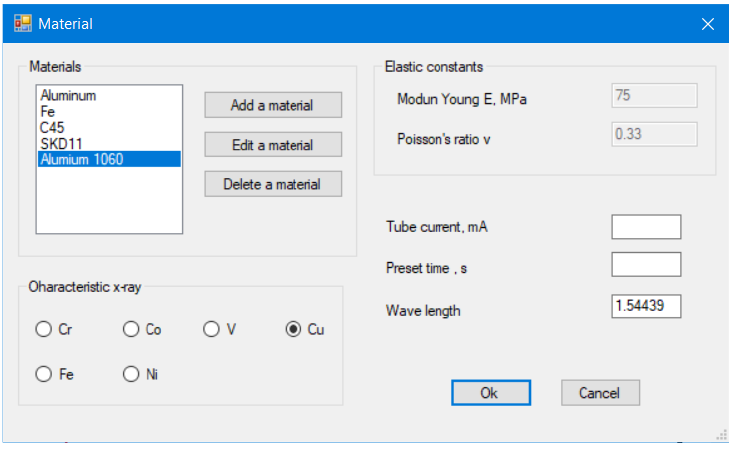
Figure 6. Elastic constants E and v of common materials for stress computation.